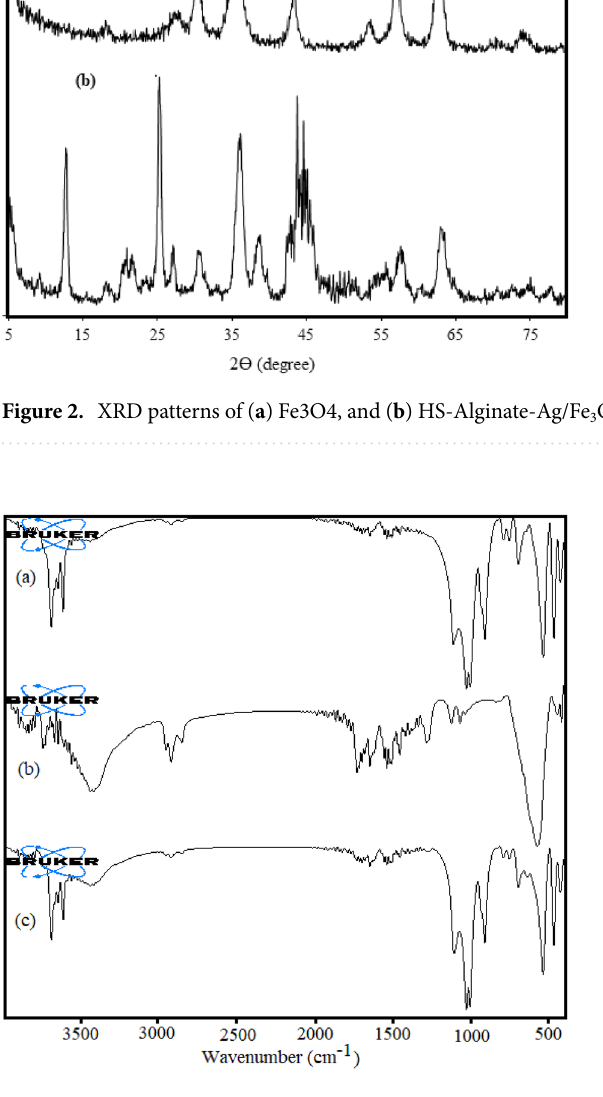
Figure 3. FTIR spectra of ( a ) HS-Fe 3 O 4 , ( b ) HS-Alginate /Fe 3 O 4 , and ( c ) HS-Alginate-Ag/Fe 3 O 4